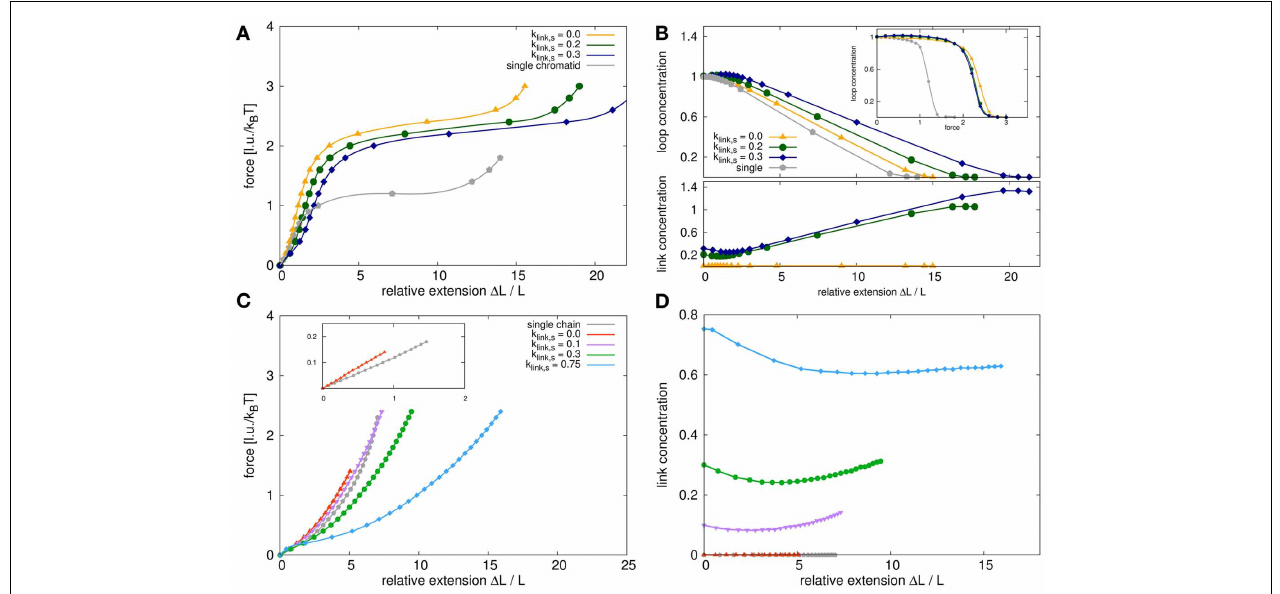
FIGURE 8 | Force extension behavior for model sister chromatids and self-avoiding walks. (A) The panel shows the stress-strain curves for model chromatid systems with different link concentrations compared to the single model chromatid. The stress-strain curves all show a characteristic behavior with a linear elongation region for small extension followed by a force plateau for larger extensions. The slope of the curves in the linear region is proportional to Young’s modulus which is a measure of elasticity. The Young’s modulus for a system of two sister chromatids which are attached at the ends but nowhere else is higher than the Young’s modulus of a single model chromatid. The Young’s modulus decreases again, if the dynamic bonding mechanism between sisters is switched on and the link concentrations is increased. The plateau region for sister chromatids is significantly higher than for a single chromatid but again decreases with increased link concentrations. (B) This figure shows the loop and link concentrations in the systems upon stress. The upper panel shows the loop concentrations within the chromatids in dependency of the relative extension. For a single chromatid and untethered sister chromatids, the loop concentration remains fairly constant in the region of small extensions and decrease for larger extensions. For